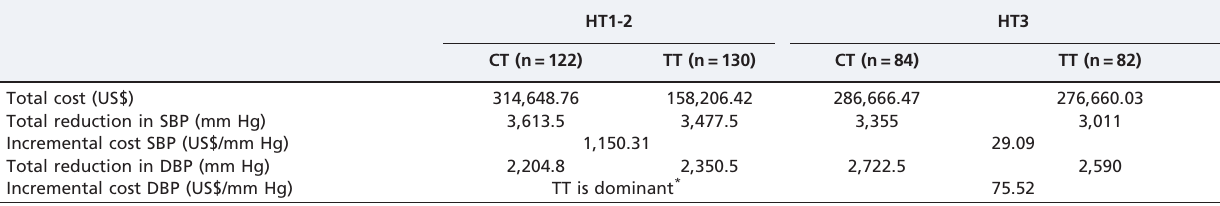
Table 3 - Incremental cost-effectiveness ratios.